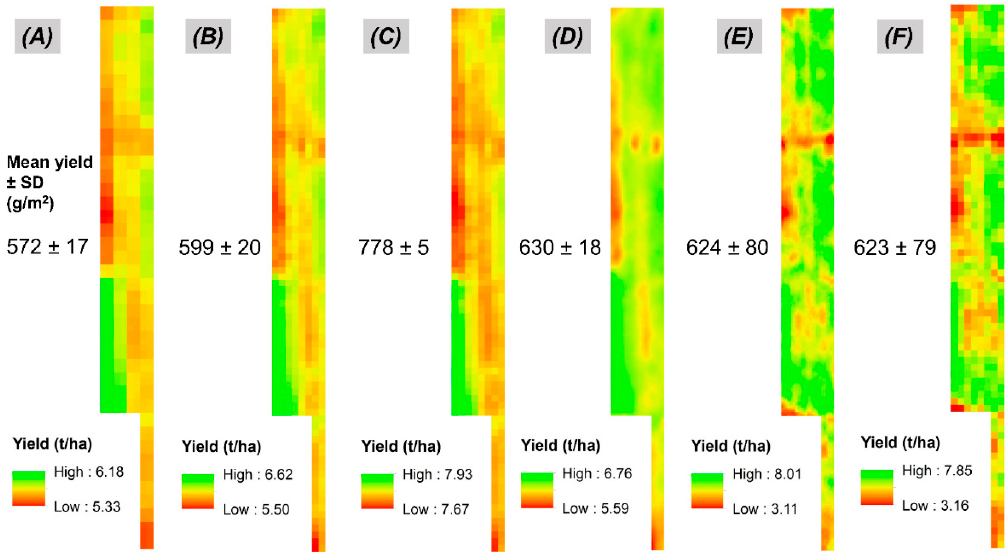
Figure 8. Predicted wheat yield from SAFY crop model using different remote sensing-based LAI inputs: ( A ) yield predicted using S2-LAI; ( B ) yield predicted using LAI derived from Sentinel-2 MSAVI and S2-LAI models; ( C ) yield predicted using LAI derived from Sentinel-2 MSAVI and field-measured LAI models; ( D ) yield predicted using LAI derived from PS-S2 fused image MSAVI and S2-LAI models; ( E ) observed yield interpolated to 3 m resolution; ( F ) observed yield interpolated to 10 m